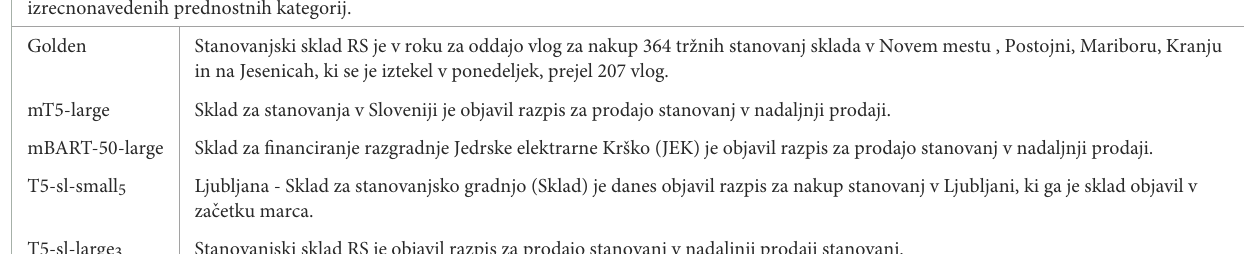
TABLE 8 Original Slovene examples of generated summaries on the ASN summarization task for the best performing models. Kandidati bodo o izboru obvešˇceni najpozneje do 3. aprila. Sklad je kot glavno željo prejel 60 vlog za stanovanja v Novem mestu, 53 za Postojno, 36 zaMaribor, 43 za Kranj in 15 vlog za stanovanja na Jesenicah. Povpraševanje je bilo najbolj izrazitoza lokacijah v Postojni in Novem mestu, kjer se sklad pojavlja prviˇc in je bil odziv zatopriˇcakovan. Sklad bo prejete vloge podrobno preuˇcil, izbor kupcev pa bo potekal 27. marca v navzoˇcnostinotarja in komisije skladno z doloˇcbami razpisa. Stanovanja, ki bodo ostala neprodana v sklopu izbora, bo sklad objavil na svoji spletnistrani www.ssrs.si 3.